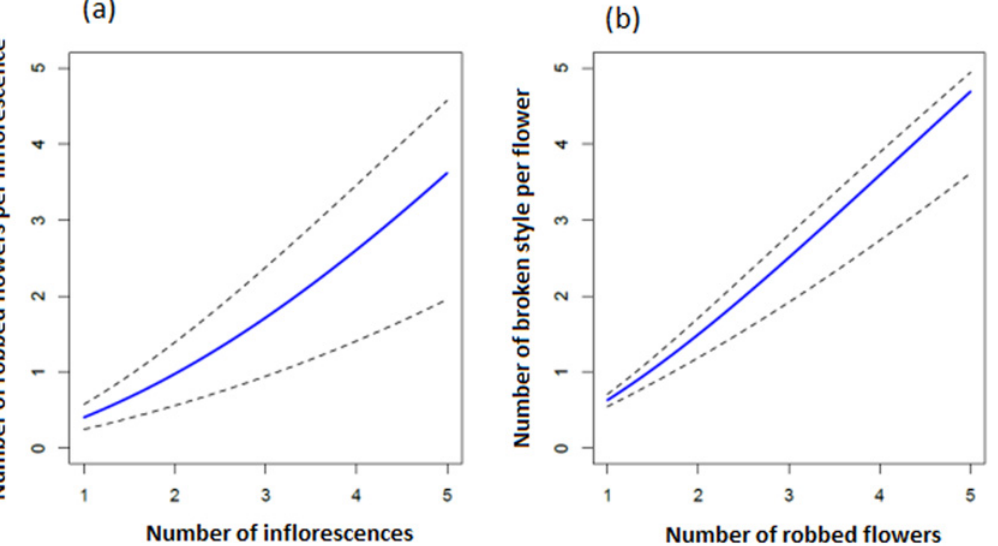
Fig 5. The relationship between (a) number of inflorescences and number of robbed flowers per inflorescence (b) number of robbed flowers and number of broken styles per robbed flowers by striped- squirrels.